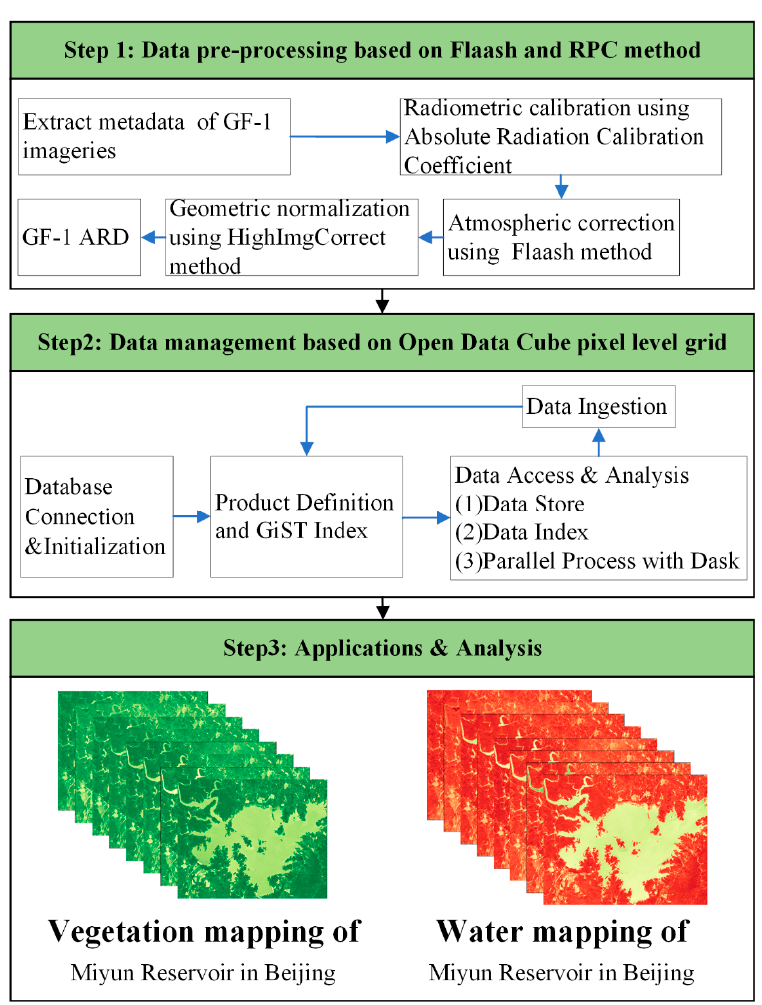
Figure 1. The Chinese GF-1 spatial and temporal satellite imagery data management framework.